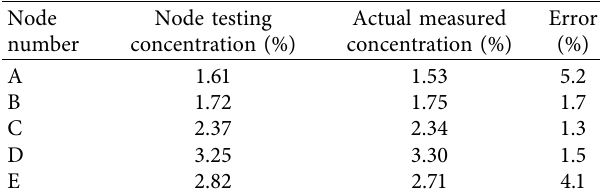
Figure 5: Test results of gas concentration acquisition module. Table 1: Comparison of methane concentration collection